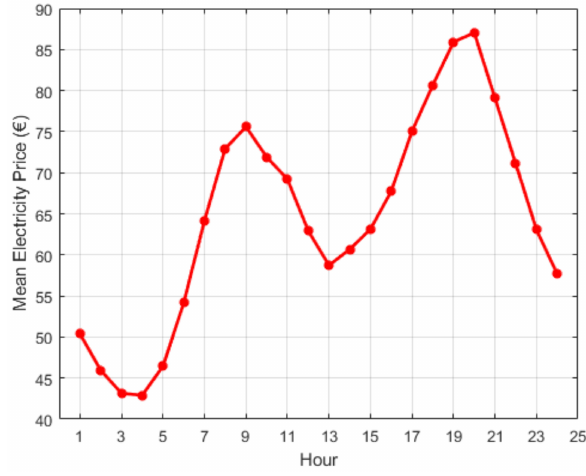
Figure 2. Mean electricity price for each hour considering all the data.